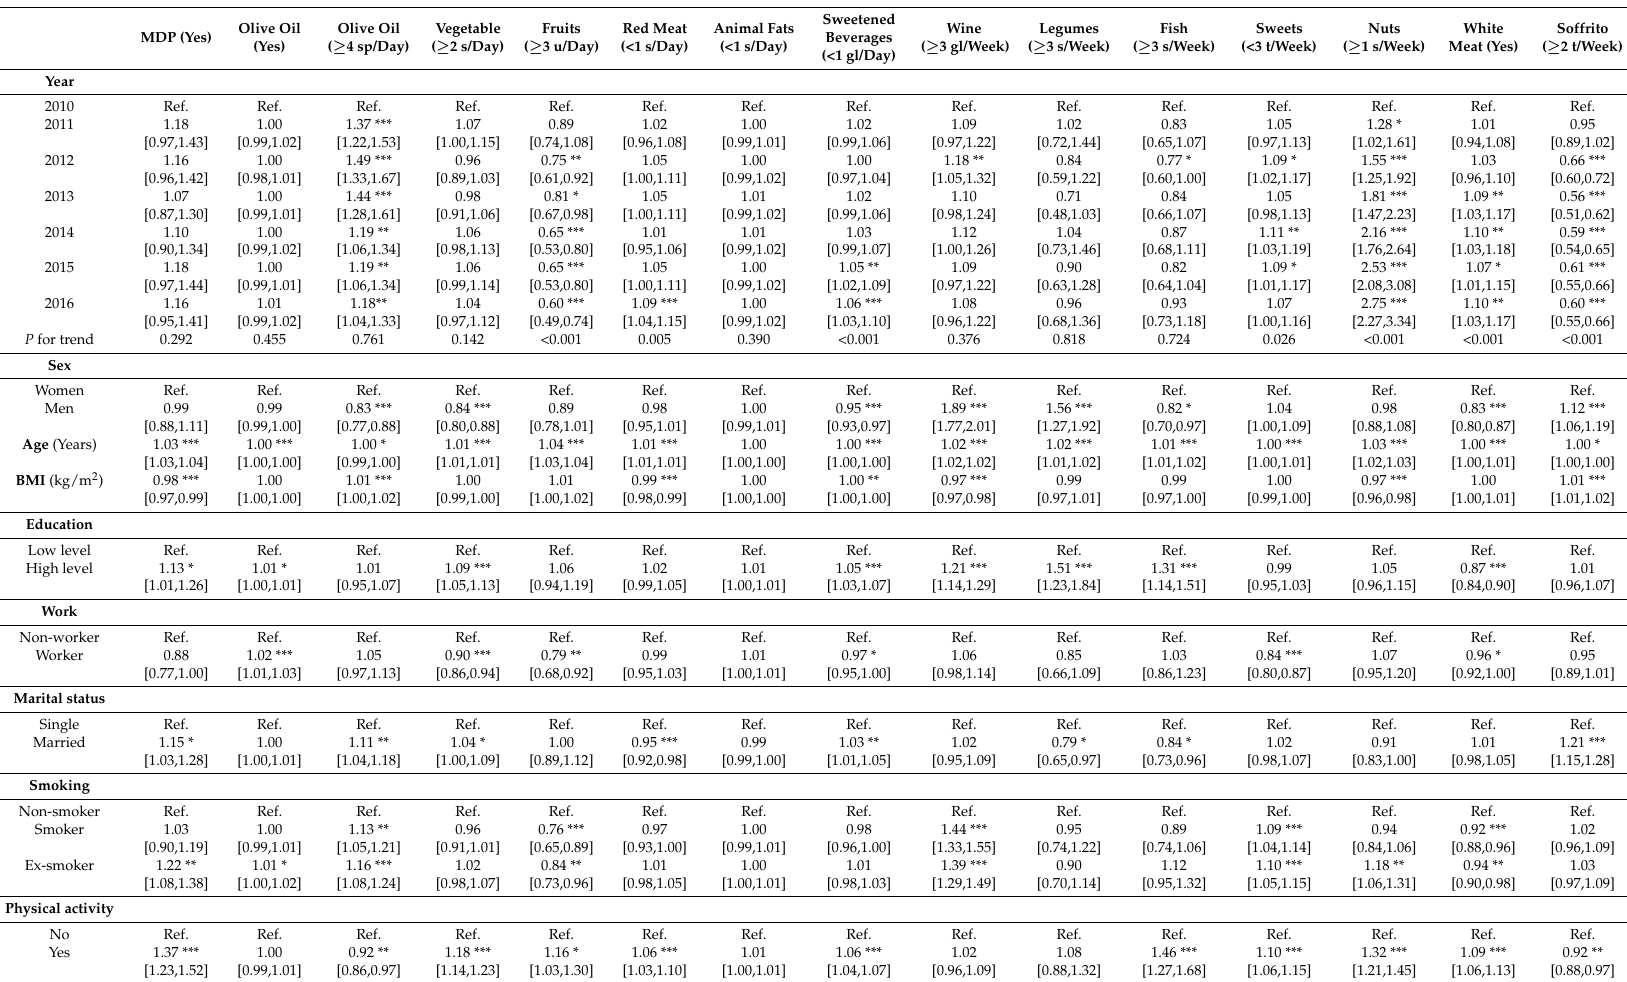
Table 3. Trends of and determinants for adherence to the Mediterranean dietary pattern (MDP) and its individual food-items. MDP(Yes) OliveOil